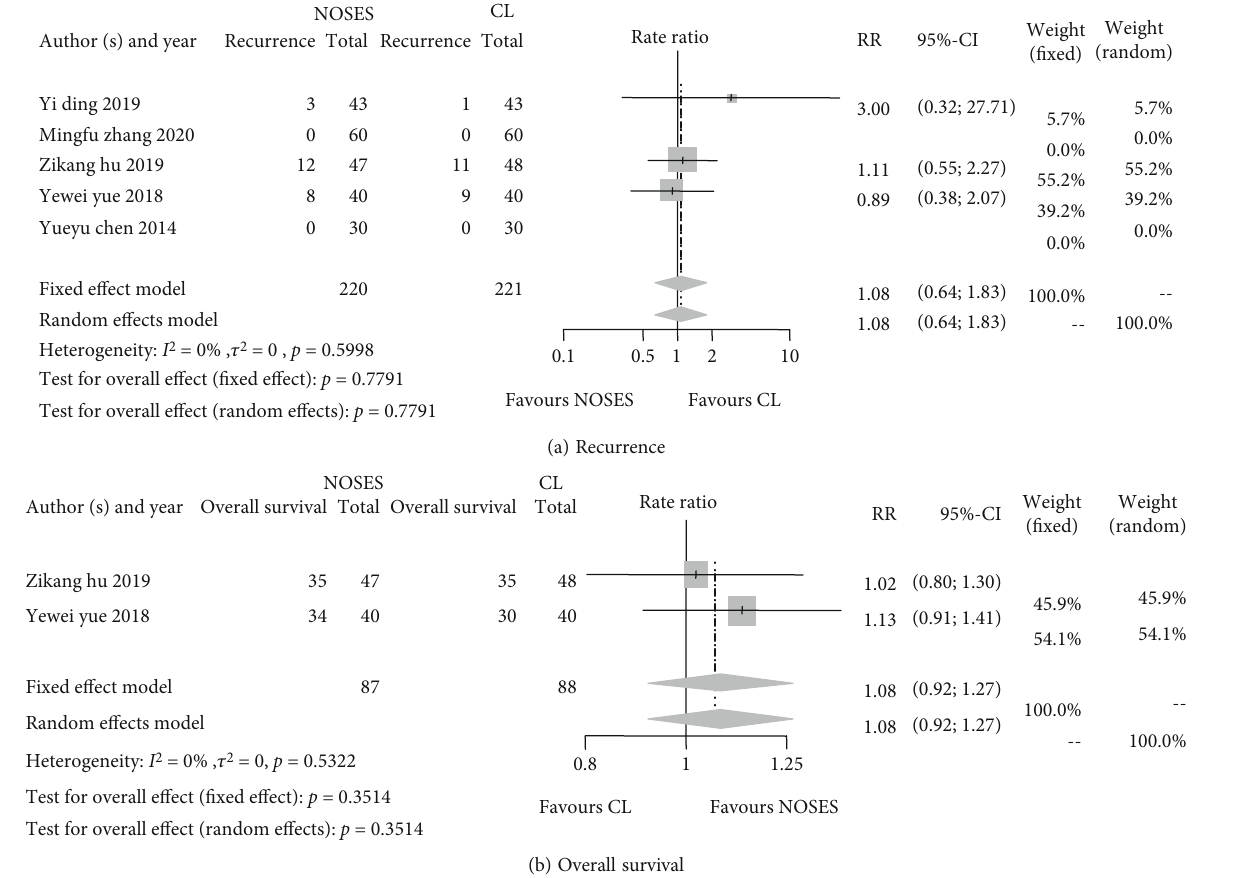
Figure 5: Forest plots of recurrence and overall survival rate between the NOSE group and the CL group. (a) Disease recurrence rate; (b) overall survival Table 5. Postoperative complications were reported in 18